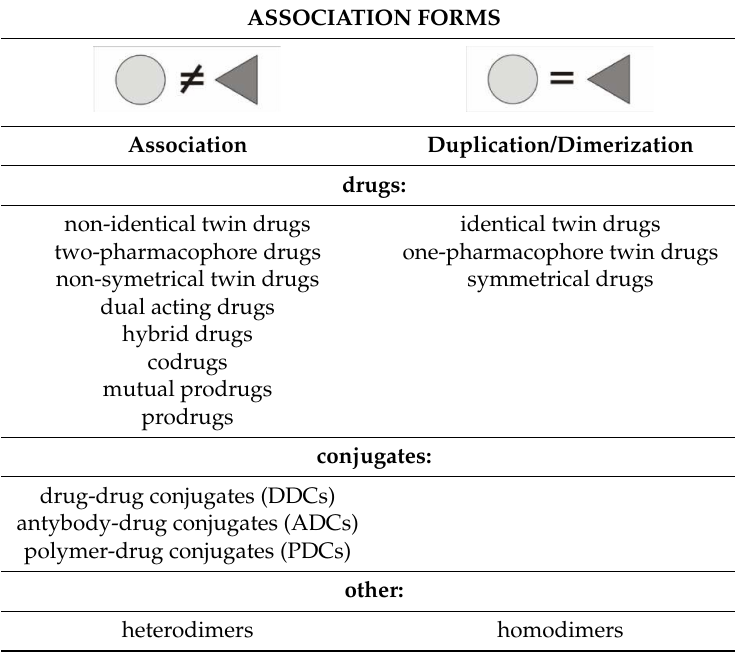
Table 2. The most common terms for hybridized